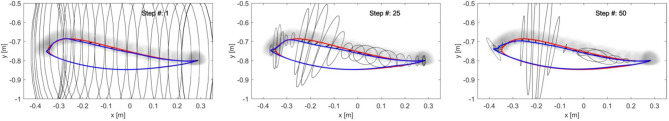
Adaptation of the end-point stiffness of the test orthosis during the simulation of a spastic-like behavior in the simulated human leg of the test bench. The initial stiffness ellipses are shown in the first box. The simulated velocity-dependent torque caused deviations of the foot trajectory at mid-swing and at the end of the swing phase. The hybrid controller adapted the stiffness ellipses magnitude and direction to provide targeted support to these deviations.